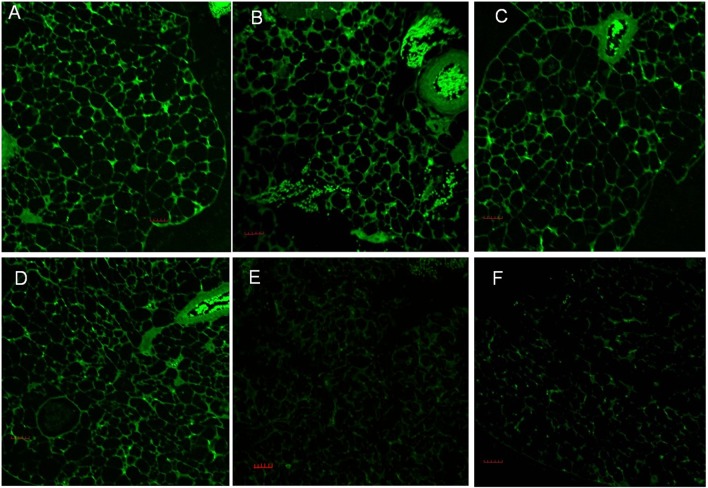
Immunofluorescent detection of α1-giardin or/and CWP2 in MLN by rabbit anti-rα1-giardin and rCWP2-S sera (200×).The expression of rα1-giardin was detected by rabbit anti-rα1-giardin sera in MLN of mouse vaccinated with SL7207/pVAX1-α1-giardin (A). The expression of rCWP2 was detected by rabbit anti-rCWP2-S sera in MLN of mouse vaccinated with SL7207/pVAX1-CWP2 (B). The co-expression of rCWP2 and rα1-giardin in mouse immunized with both SL7207/pVAX1-α1-giardin and SL7207/pVAX1-CWP2 were detected by rabbit anti-rα1-giardin sera (C) and by rabbit anti-rCWP2 sera (D). No obvious fluorescence was detected in the sections of MLNs of mice immunized with SL7207/pVAX1-α1-giardin (E) and with SL7207/pVAX1-CWP2 (F) probed with normal rabbit serum. The bar is 50 μm.